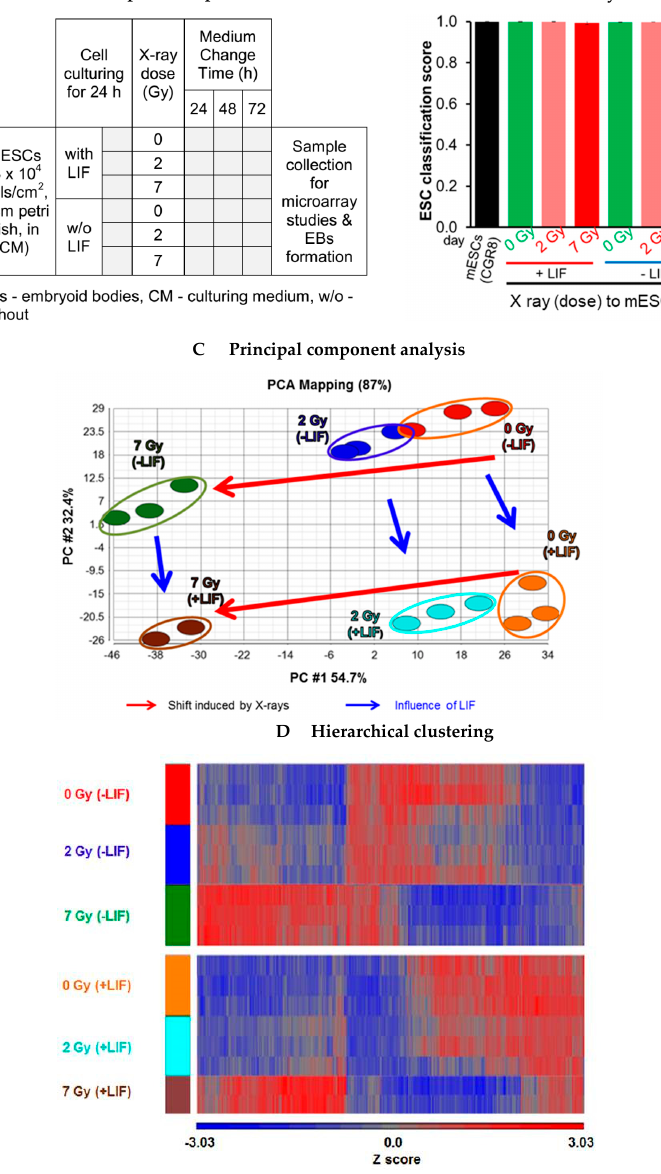
Figure 8. Gene expression of mESCs after X-rays exposure. ( A ) mESCs cells were cultured on Petri dishes for 24 h and then exposed to X-rays doses of 0 Gy, 2 Gy and 7 Gy. The cells were then maintained in the presence or absence of leukemia inhibitory factor (LIF) for 72 h. The cells were collected after 72 h for microarray studies and embryoid bodies (EBs) formation. ( B ) CellNet analysis revealed a uniform ESC classification score for mESCs exposed to 0 Gy, 2 Gy and 7 Gy and further cultured for 72 h in the presence and absence of LIF. ( C ) The data structure of transcriptome (data sets based on X-ray deregulated genes (fold change ≥ ± 2, p < 0.05) was dimensionality-reduced and presented in form of a 2D principle component analysis (PCA) diagram. The PCA illustrates a distance along PC #1, which primarily denotes an X-rays-induced shift whereas PC #2 represents the LIF-induced shift. ( D ) All transcripts whose expression was significantly modified (fold change ≥ ± 2, p < 0.05) after exposure to X-rays were used for the hierarchical cluster analysis (unsupervised, Partek Genomics Suite (PGS)). The results are represented as a heat map with each row representing one experiment, each column indicating data for one probe set and the color of each cell indicating the row-wise z-score of gene expression levels (blue: decreased low; red: increased). The data represent the mean of three independent